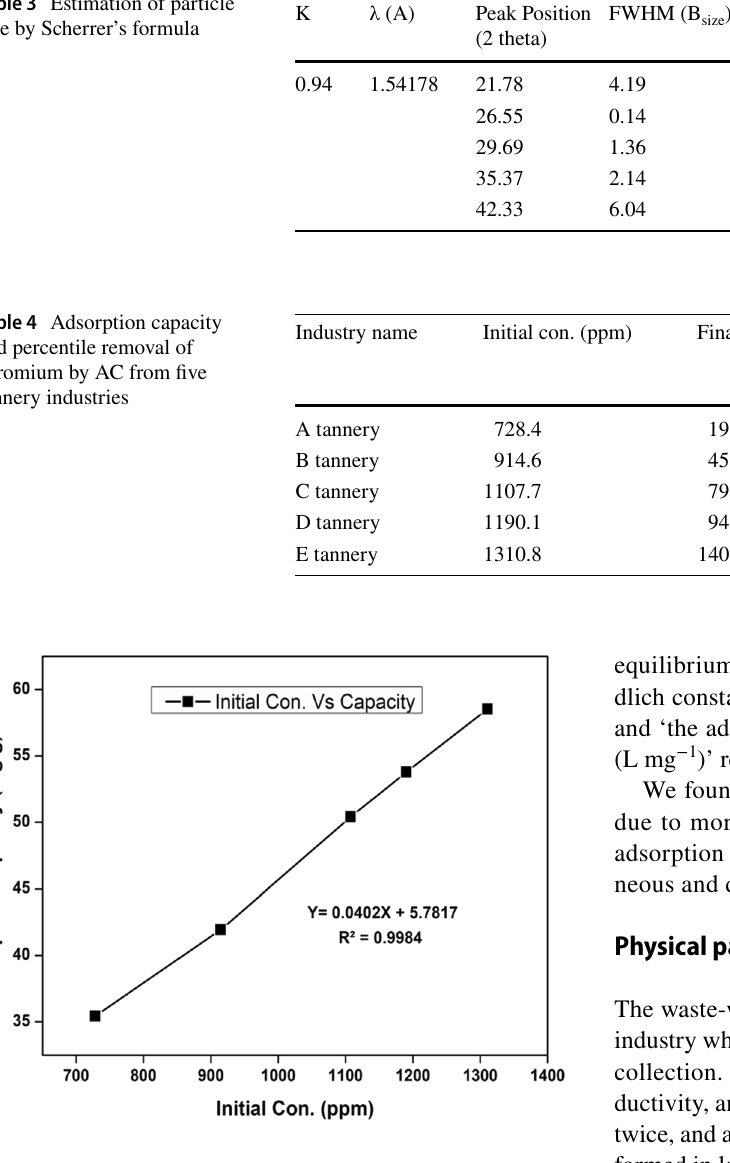
Fig. 4 Adsorption capacity at various initial concentration of chro- mium by AC from tannery